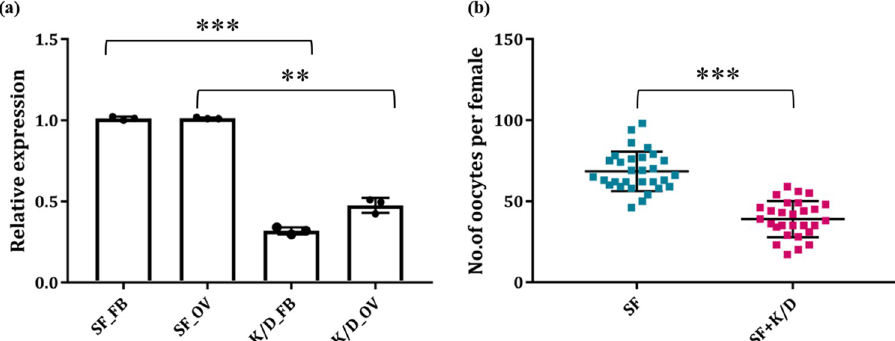
Fig 6. AcTrf1a silencing effect on mosquito oocyte development. (a) Real time-PCR based knockdown validation of AcTrf1a in fat-body ( p < 0 . 0001 ) and ovary ( p < 0 . 0052 )tissue after dsAcTrf1a injection to newly emerged mosquitoes in comparison to same age group dsLacZ injected (n = 25, N = 3). Data represented in the figure were from three independent biological replicates, where each dot is equivalent to replicate. Statistical analysis was done using one-way ANOVA viz � p < 0.05; �� p < 0.005; and ��� p < 0.0005, ( n = represents the number of mosquitoes pooled for sample collection; N = number of replicates); FB, fat-body; OV, ovary. (b) Dot plot showing the comparative oocyte count reduction ( p < 0 . 00001 ) post AcTrf1a knockdown in female ovary tissue compared to control mosquito group. Post dsr injection mosquitoes were fed on blood meal and ovary assessment was done, (n = 10, N = 3). Data represented in the figure were from three independent biological replicates, where each dot represent number of mature follicles per female. Statistical analysis was done using Mann–Whitney U test ( n = represents the number of mosquitoes pooled for sample collection; N = number of